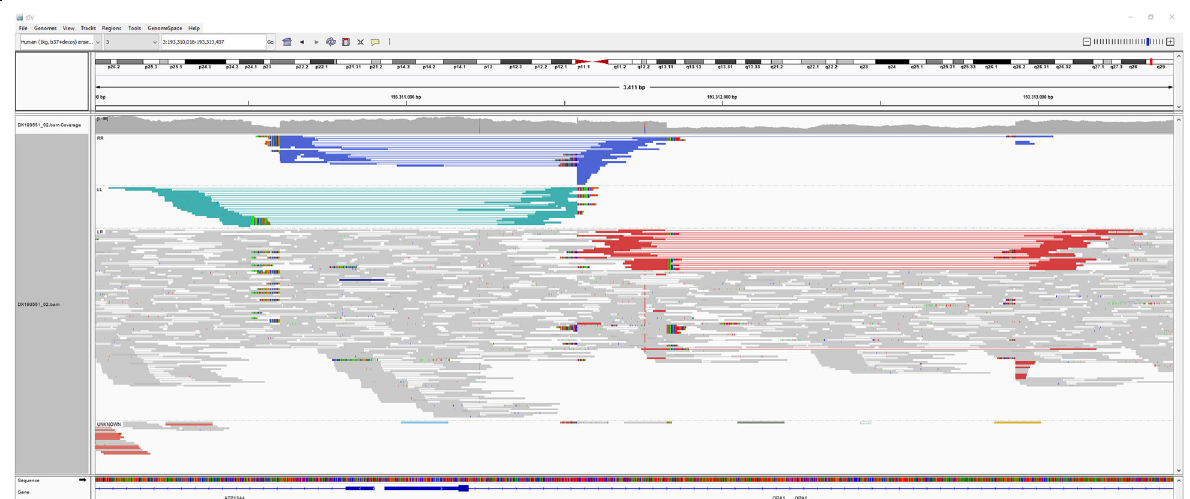
Fig. 3 Integrative Genomics Viewer (IGV) screenshot of the genomic region containing the structural variant identified in the affected proband. From top to bottom the read coverage track, the alignment track (reads colored by insert size and pair orientation and grouped by pair orientation) and the gene track are shown. Colored reads represent discordant reads with unexpected insert size and/or pair orientation when aligned to the reference genome indicating the structural variant. Blue read pairs/lines represent read pairs with right-right pair orientation, teal reads represent read pairs with left-left pair orientation and red read pairs/lines represent read pairs with aberrant insert size. Split reads with soft- clipped bases span the breakpoints of the structural variant